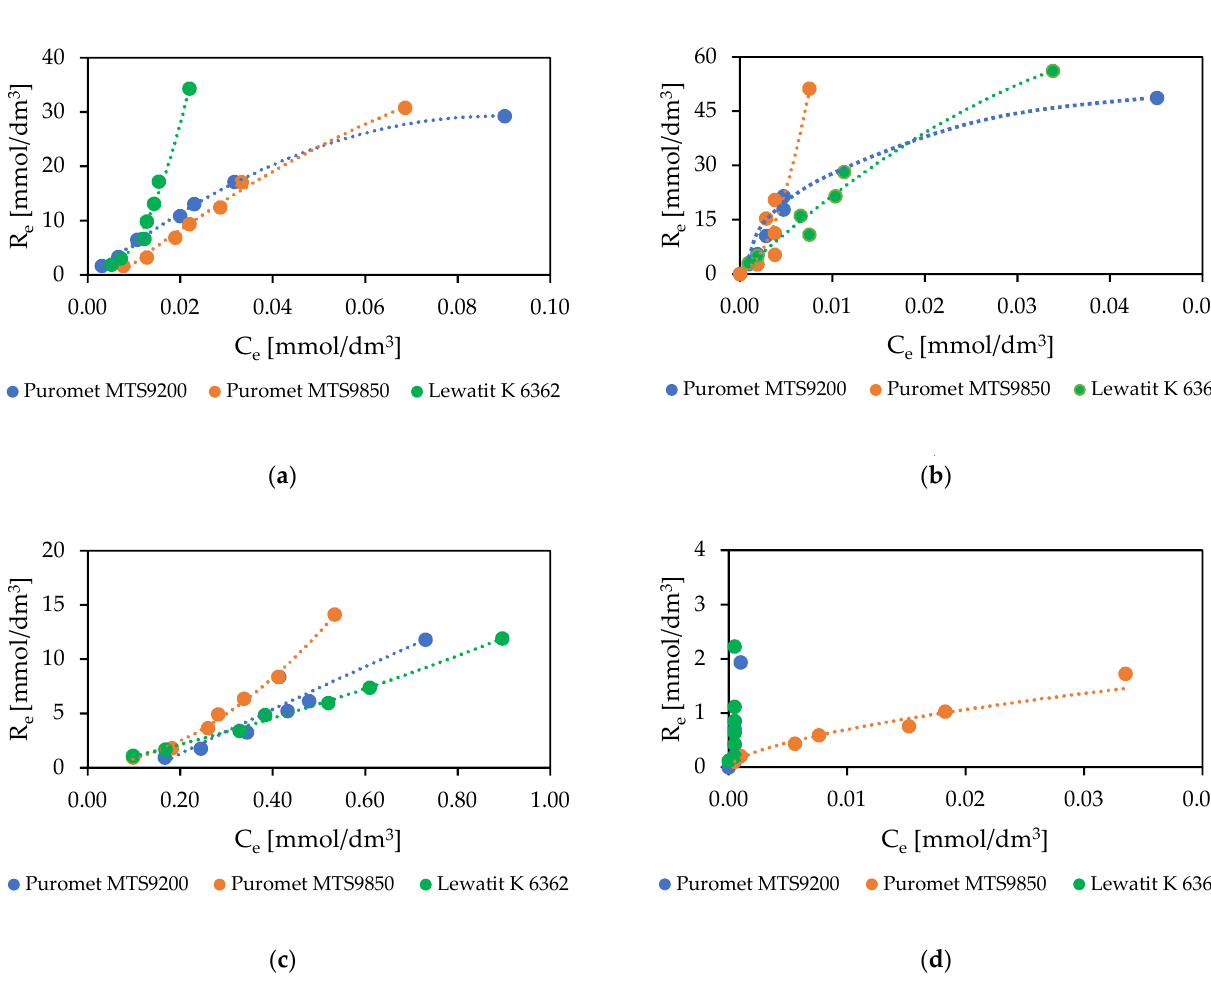
Figure 3. Sorption isotherms (T = 20 °C); for ( a ) platinum, ( b ) palladium, ( c ) rhodium, and ( d ) gold; C e —concentration of the metal in the solution in equilibrium, R e —concentration of the metal in the resin in equilibrium.